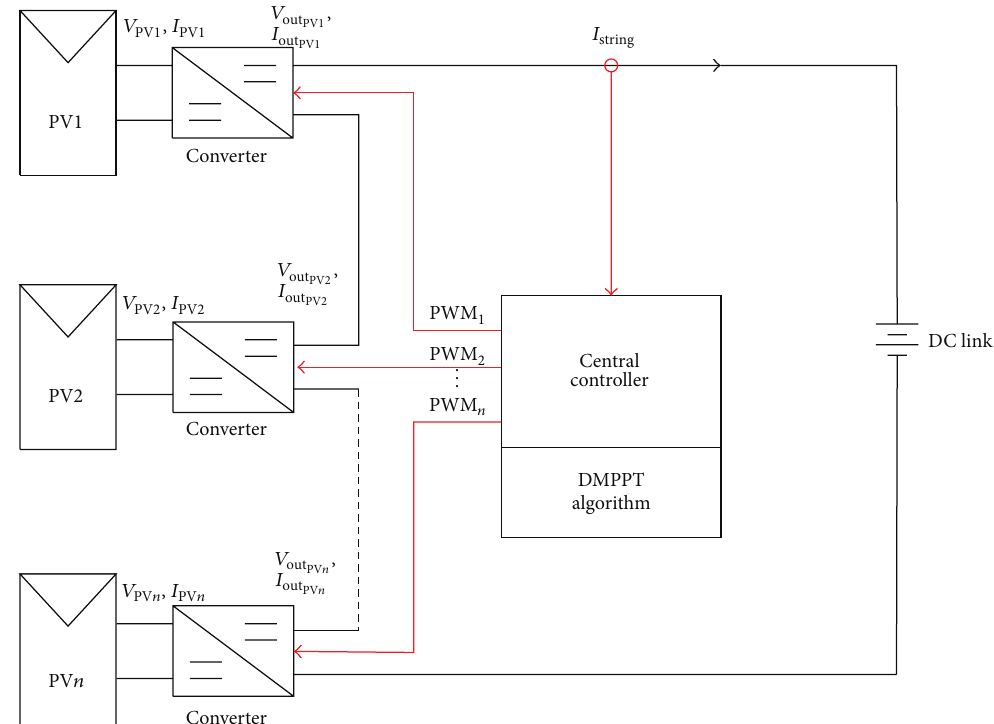
Figure 8: The schematic arrangement of a distributed PV system using the multivariable particle swarm optimization method.